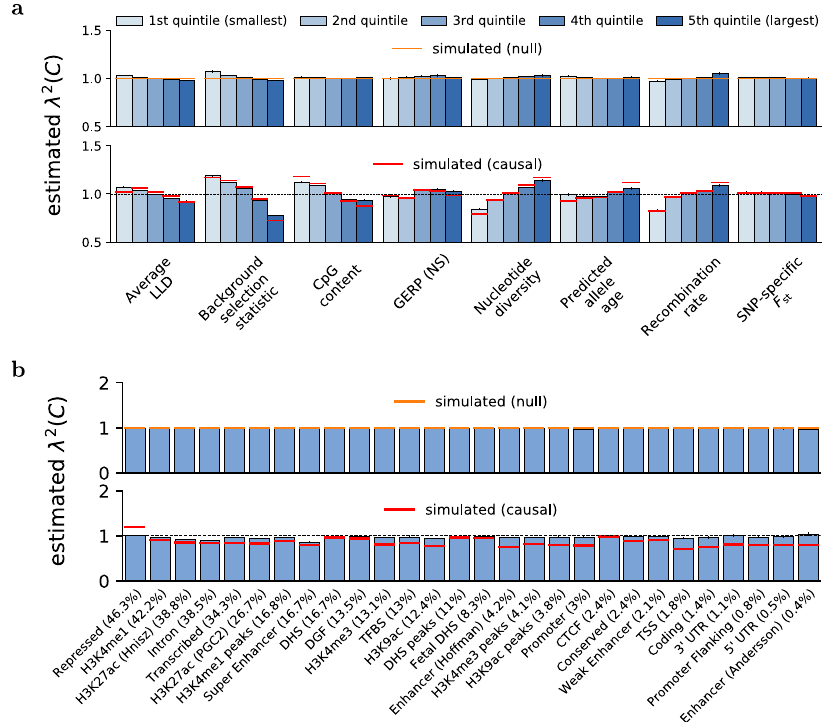
Fig. 1 Accuracy of S-LDXR in null and causal simulations. We report estimates of the enrichment/depletion of squared trans-ethnic genetic correlation ( λ 2 ( C )) in both null and causal simulations, for ( a ) quintiles of 8 continuous-valued annotations and ( b ) 28 main binary annotations (sorted by proportion of SNPs, displayed in parentheses). Results are averaged across 1000 simulations. Error bars denote ± 1.96 × standard error of the mean. Numerical results are reported in Supplementary Data 4 and